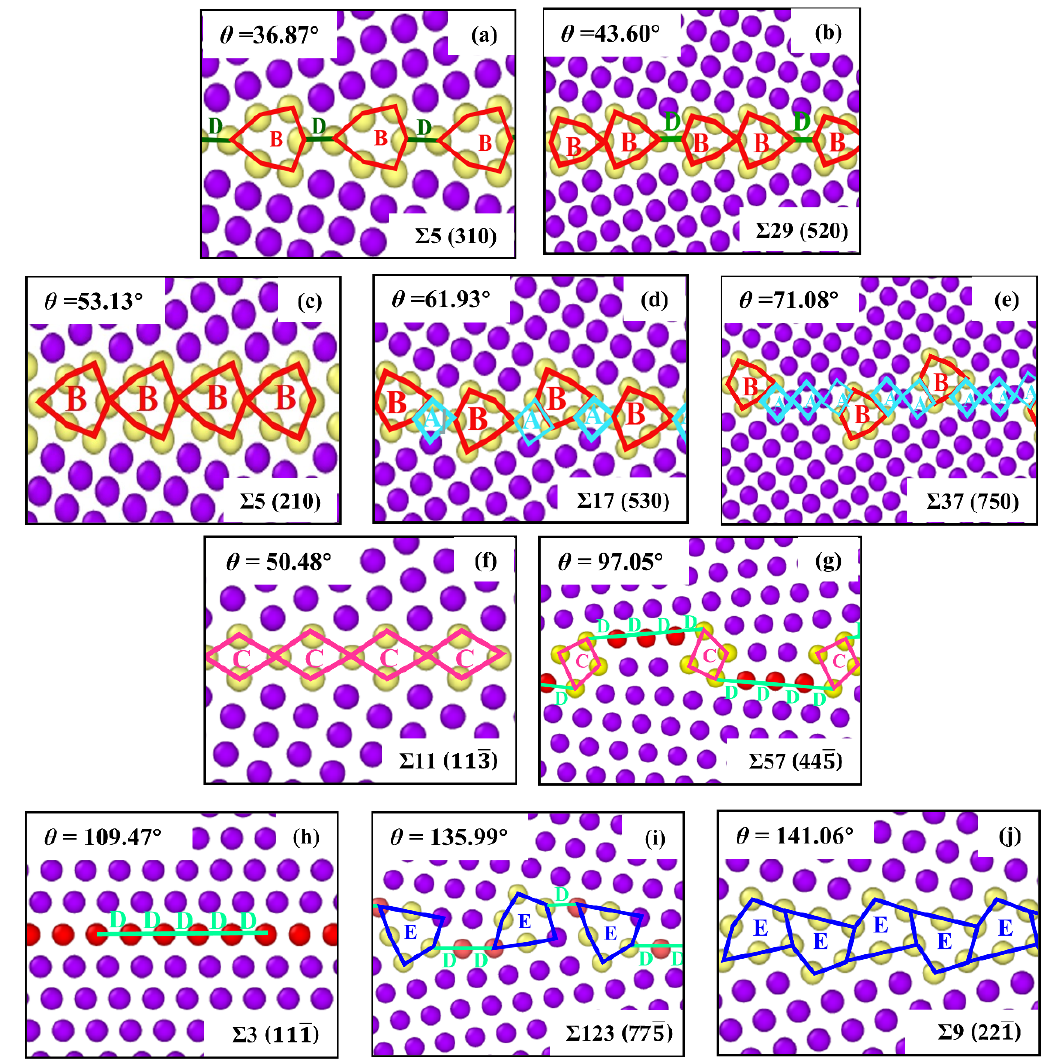
Figure 2. The atomistic configurations of several GB structure units along ( a – e ) < 001 > tilt axis and ( f – j ) 110 tilt axis. Images are colored by CNA, where the atoms in FCC structure are colored in purple, the atoms in HCP structure are colored in red, the atoms in other structure are colored in yellow.